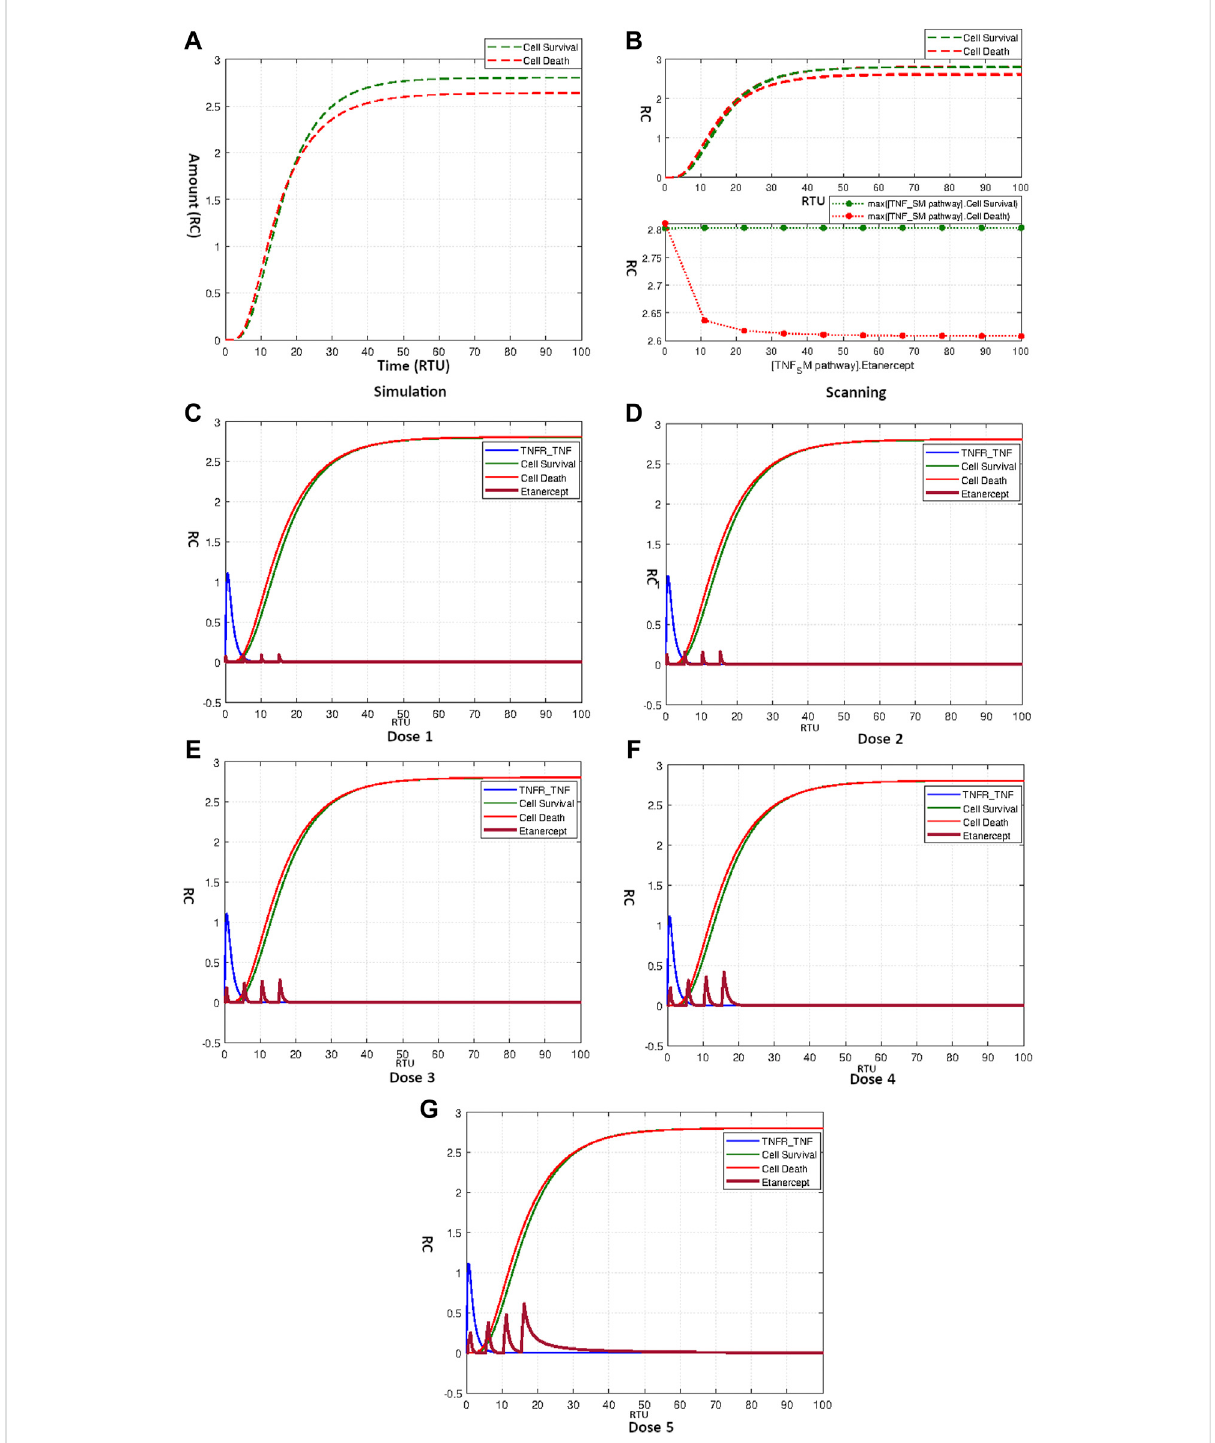
FIGURE 9 (A) Simulation showing effect of Etanercept on Neuronal Survival and Death. (B) Scanning of Etanercept performed over range 0 – 100 shows only minor decrease in cell death. (C – G) Figures c to g represent the dosage graphs for Etanercept according to Table 4. Dosages (C – G) have no obvious effect on neuronal death and